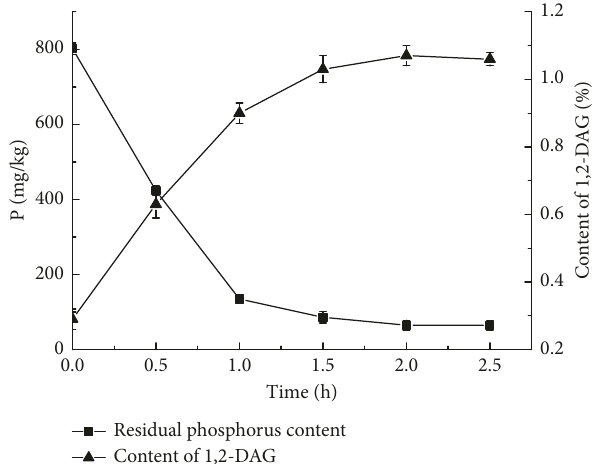
Figure 6: Content of residual phosphorus and 1,2-DAG changes with time. The degumming conditions were at 65 ° C and pH of 7.5 for 2.5 h in crude soybean oil. After reacting for 2.0 h in crude soybean oil, the residual phosphorus and 1,2-DAG were 64.7 mg/kg and 1.07%, respectively. The data were reproduced three times, and error bars indicate standard deviations.